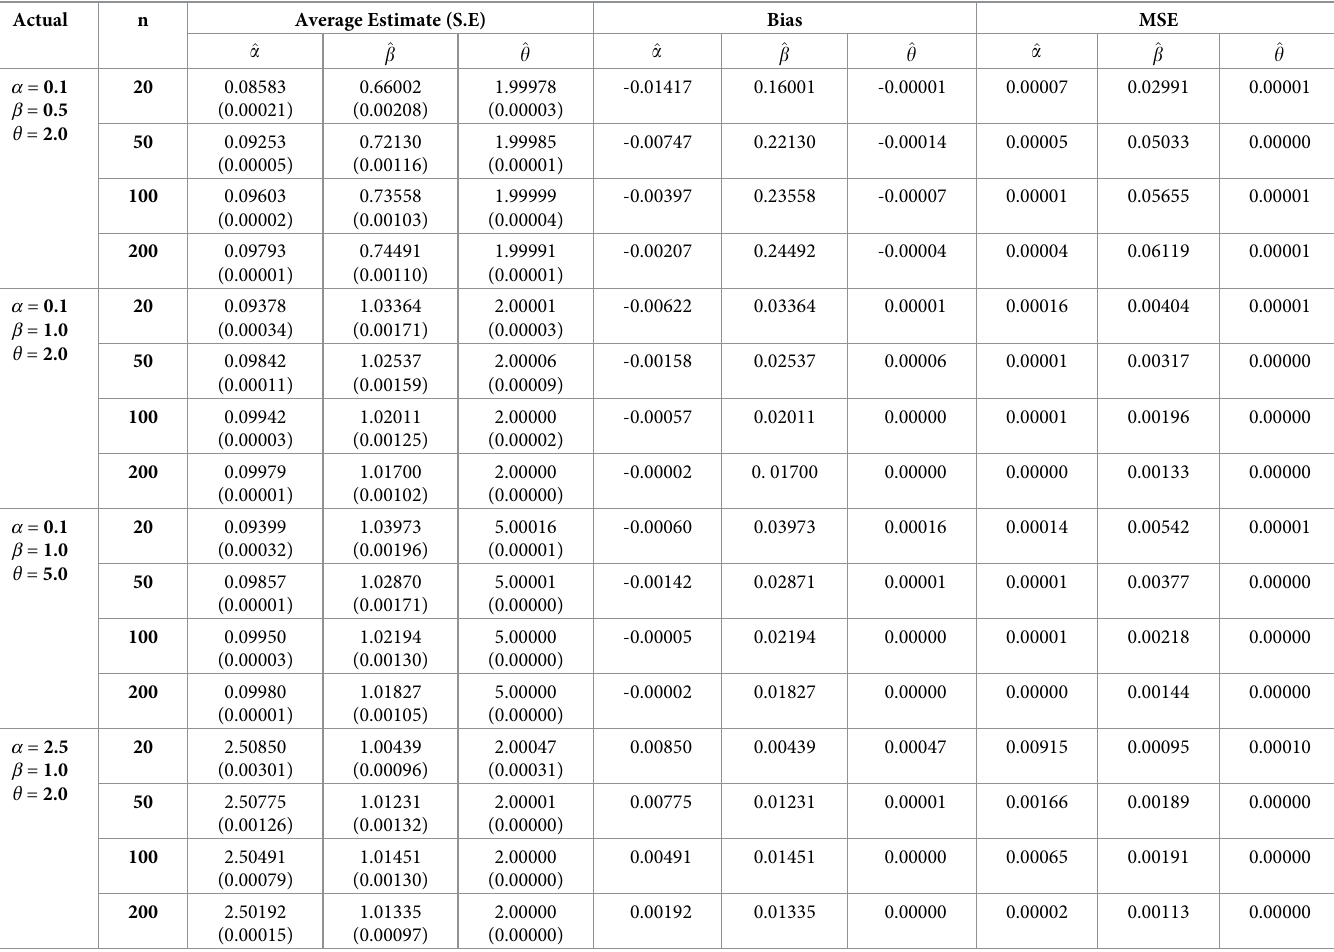
Table 1. Average estimated values, corresponding SEs (given in parentheses) bias and MSE of model